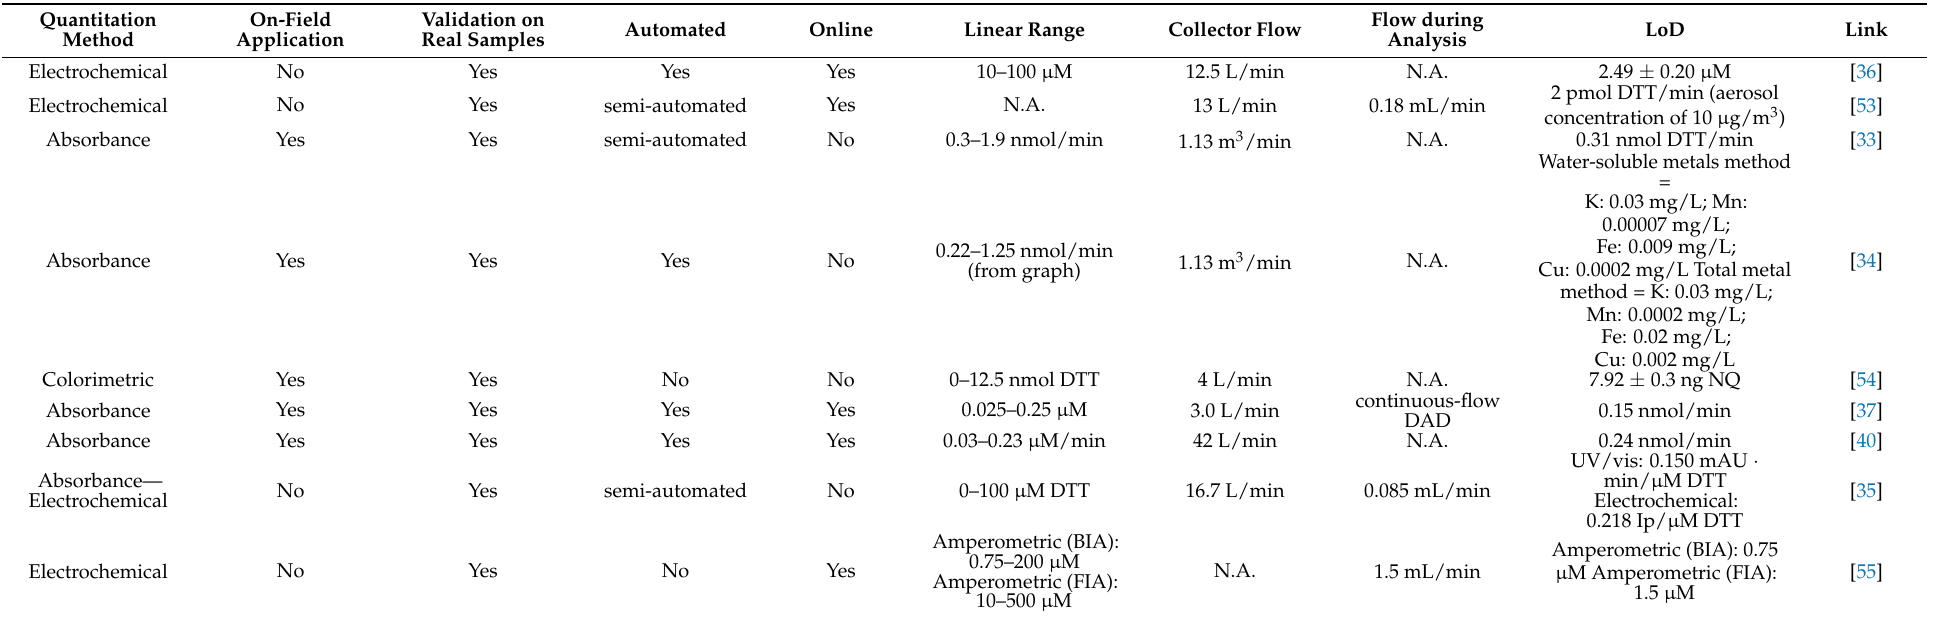
Table 2. Automated and online systems based on DTT